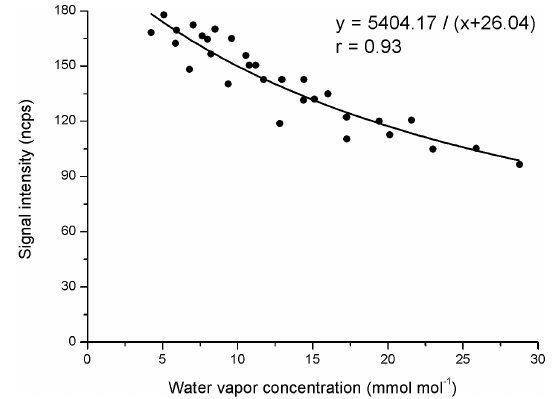
Figure 7. The relationship of the signal intensity at m/z 31 and the water vapor concentration in sample air.